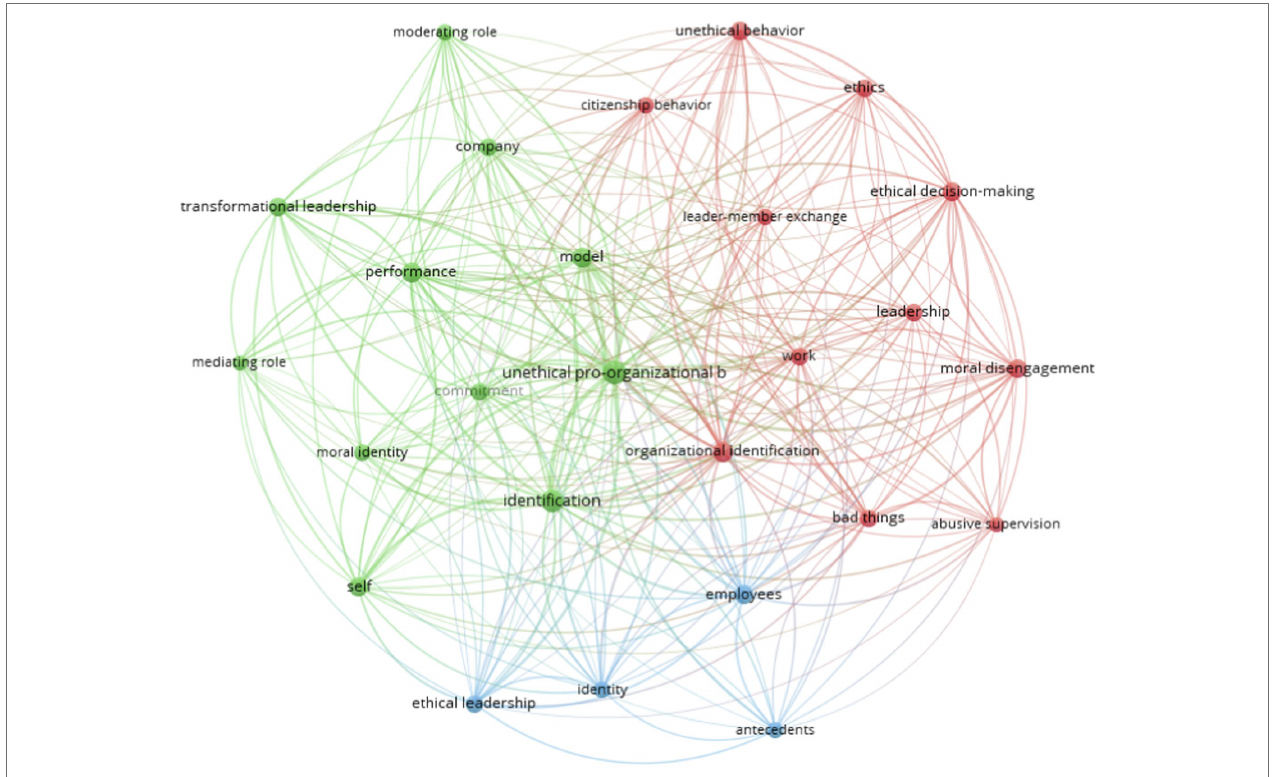
FIGURE 3 | Keywords co-occurrence network in UPB